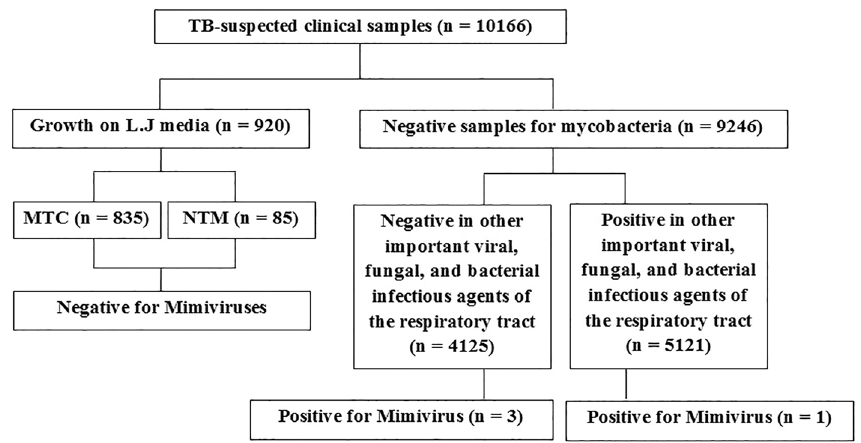
Figure 1. Flow chart of the study population selection. TB, Tuberculosis; MTC, Mycobacterium tuberculosis complex; NTM, nontuberculous